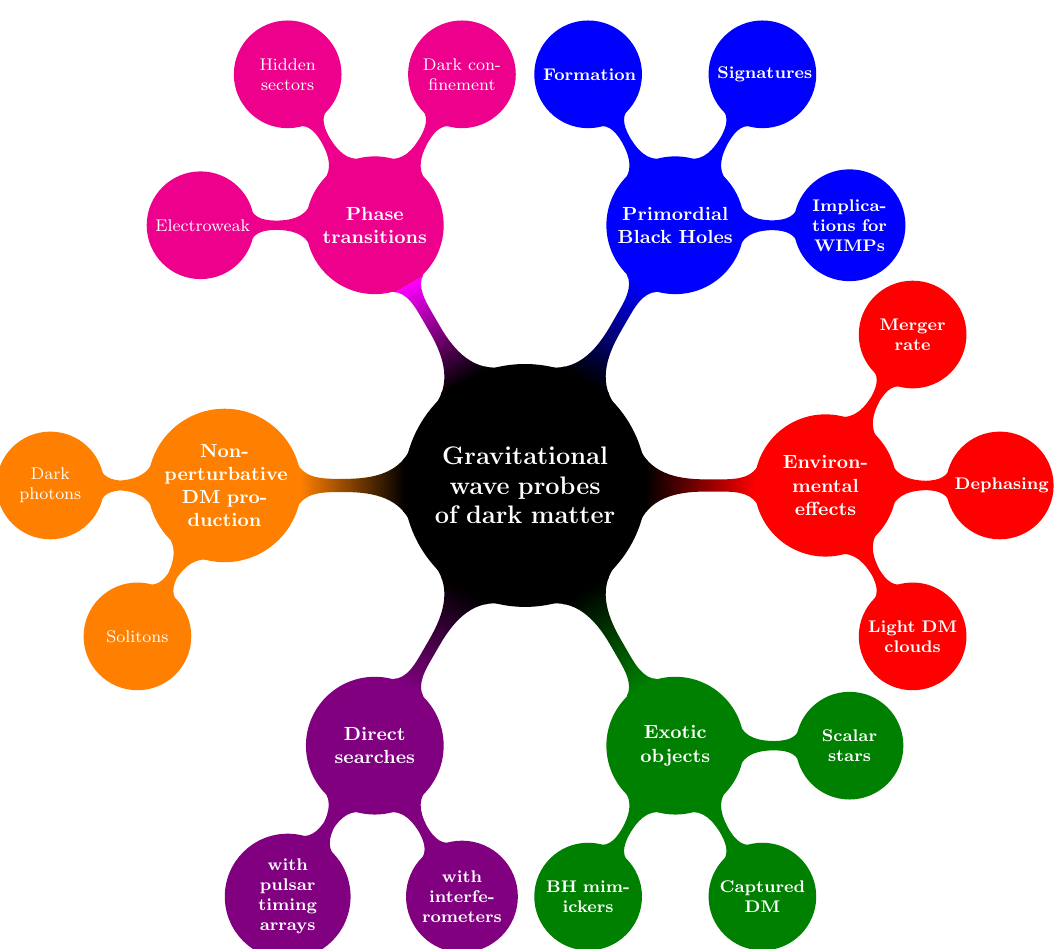
Figure 1: Mind map of gravitational wave probes of dark matter. See text for